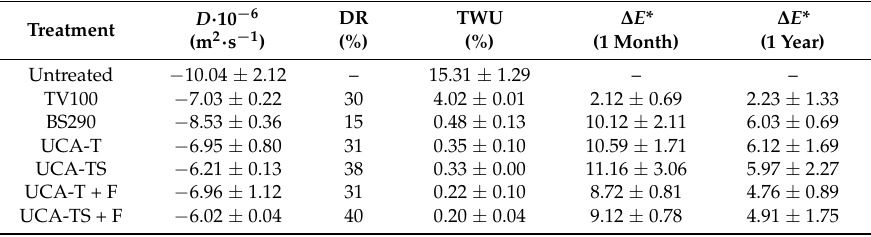
Table 2. Vapor diffusivity ( D ), total water uptake by capillarity (TWU) and total color difference ( ∆ E *) for each treatment and its untreated counterpart. For each value of D , the percentage of reduction (DR) with respect to the untreated stone is also given.